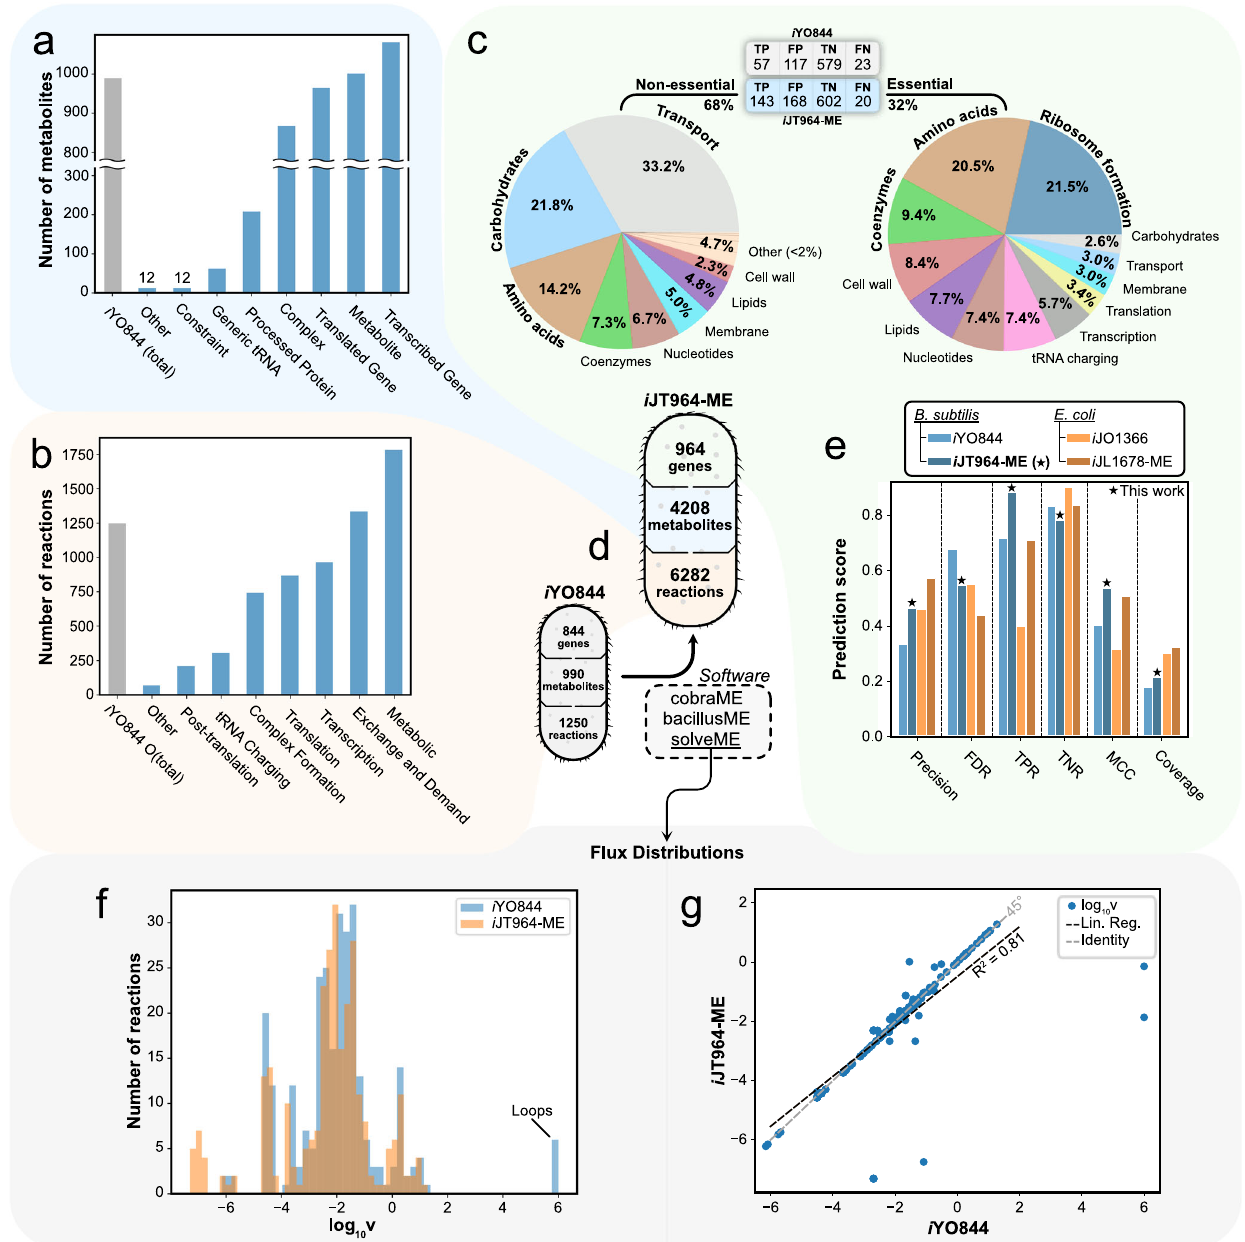
Fig. 1 Properties of i JT964-ME and gene essentiality prediction performance. a Breakdown of metabolite types included in the model. Complex: active enzyme, Constraint: biomass component, Generic tRNA: tRNA, Metabolite: standard metabolite, Processed Protein: monomer before complexation, Transcribed Gene: mRNA, Translated Gene: protein before any modi fi cation. b Breakdown of reaction types included in the model. Metabolic: reactions inherited from i YO844, Exchange and Demand: inlet and outlets of the model, Transcription: mRNA synthesis, Translation: protein synthesis, Complex Formation: complex synthesis, tRNA charging: charged tRNA synthesis, Post-translation: protein modi fi cation, Other: biomass constraints. c ME-model predictions of gene essentiality; distribution of essential and non-essential genes. In between the pie charts, a table shows the confusion matrix for the essentiality predictions in i YO844 and i JT964-ME. d Number of genes, metabolites, and reactions included in the model. e Accuracy scores for predictions of gene essentiality by B. subtilis and E. coli models (M- and ME-models). Predictions were contrasted with the reported essential genes by Juhas et al. 41 for B. subtilis and in EcoCyc 42 for E. coli . Score calculations of Precision, False Discovery Rate (FDR), True Positive Rate (TPR), True Negative Rate (TNR), and Matthews Correlation Coef fi cient (MCC) are explained in “ Methods ” . f Histograms showing the fl ux distributions of metabolic reactions for both i YO844 and i JT964-ME. v , with v representing fl ux Considering the vast range in orders of magnitude across fl uxes, here we show their distribution in terms of log 10 v of the metabolic reactions in i YO844 and i JT964-ME. Correlation is shown with a linear (see “ Methods ” ). g Comparison in terms of log 10 regression and a Pearson correlation coef fi cient ( R 2 ).